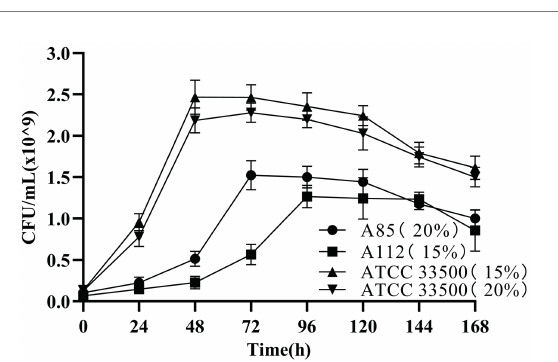
FIGURE 1 The growth of strains ATCC 33500(15% NaCl; 20% NaCl), A85(20% NaCl) and A112(15% NaCl) in SE medium were indicated by CFU counting. All the data are presented as means of duplicates with their standard